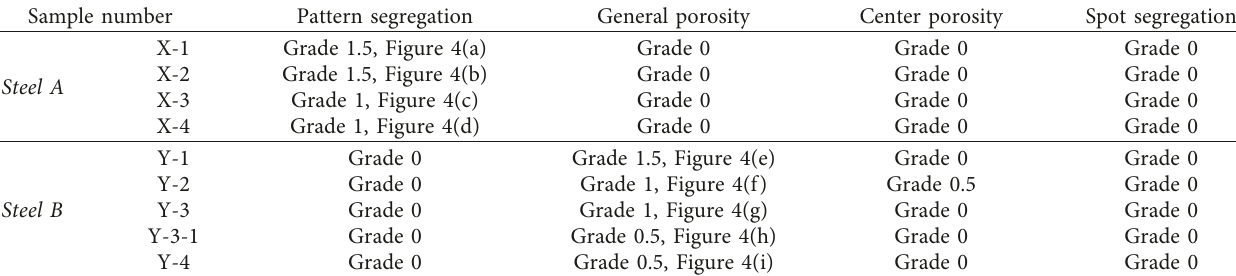
Figure 4: Low magnification morphology. (a) Sample X -1. (b) Sample X -2. (c) Sample X -3. (d) Sample X -4. (e) Sample Y -1. (f) Sample Y -2. (g) Sample Y -3. (h) Sample Y -3-1. (i) Sample Y -4. Table 3: Low magnification structure observation